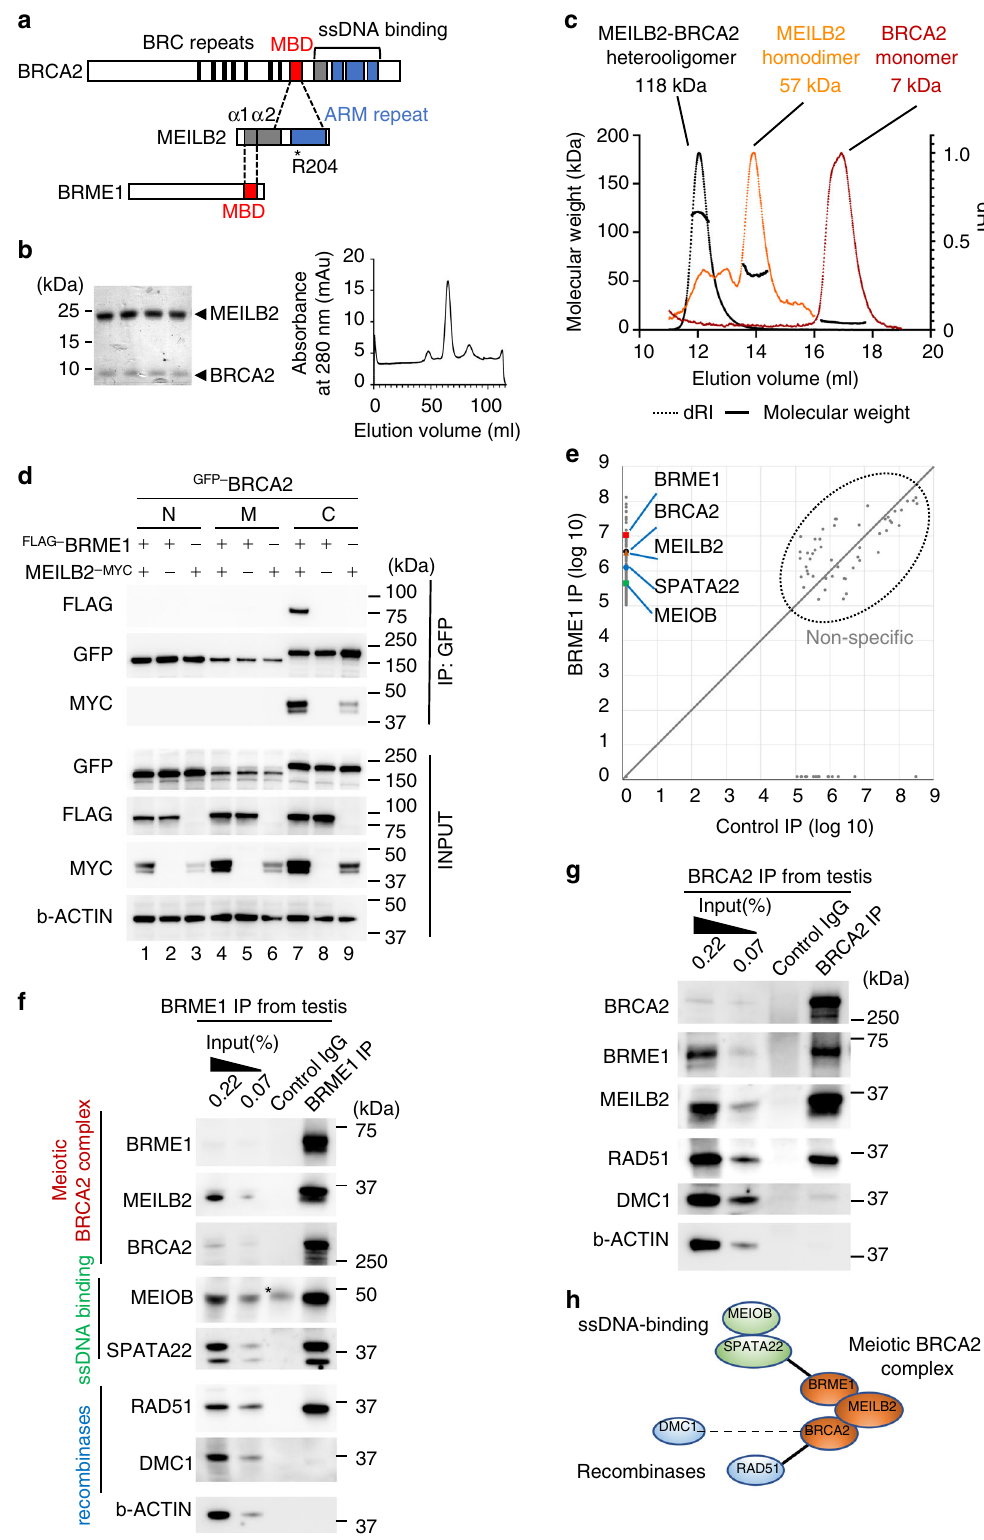
MEILB2 signal intensity and foci number, respectively, compared with WT (Fig. 4h, i). These faint foci still resided on chromosome axes (Fig. 4h) and colocalized with RPA2 (Supplementary Fig. 4a) as in WT spermatocytes, suggesting that these faint foci were not background signals. Western blotting of testes extracts showed that the protein level of MEILB2 was also decreased in Brme1 − /